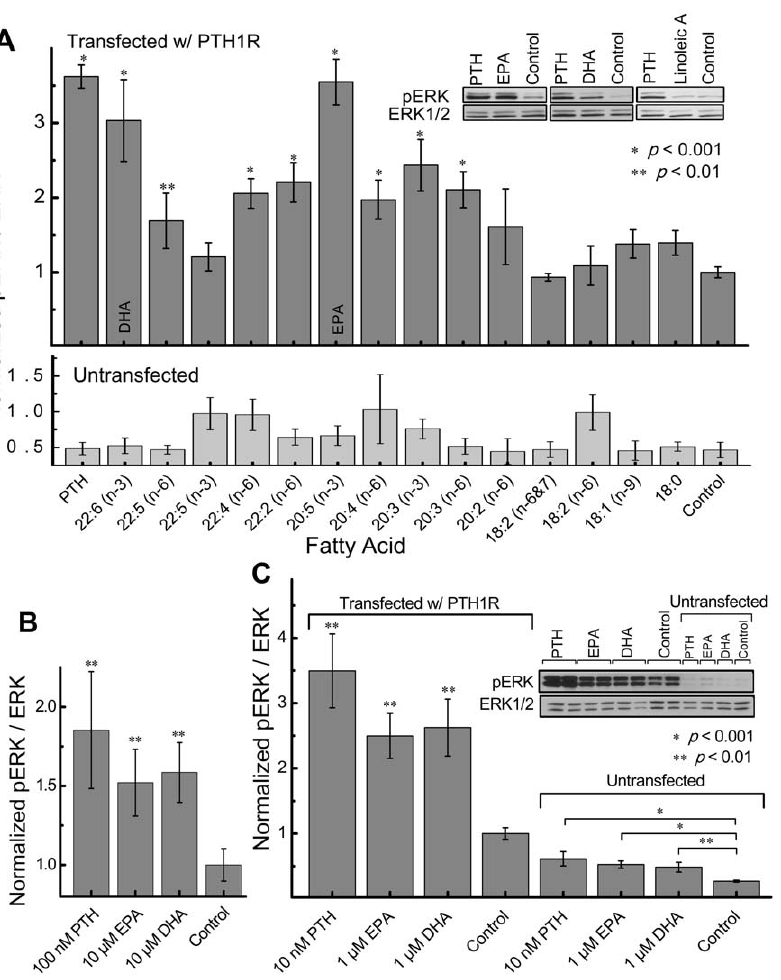
Figure 1. Activation of PTH1R by fatty acids in (A, B) HEK293 and (C) MC3T3-E1 cells. PTH(1–34) concentration in (A, B) was 100 nM (positive control). Fatty acids concentrations were 10 m M. HEK293 cells were transfected with PTH1R as described under Materials & Methods and treated for (A) 5 minutes or (B) 15 seconds. (C) PTH(1–34) concentration was 10 nM (positive control). Fatty acid concentrations were 1 m M. MC3T3-E1 cells were transfected with PTH1R as described under Materials & Methods. Cells were stimulated with PTH(1–34) or corresponding fatty acid in PBS for 5 minutes at 37 u C. Western blots were used to determine ERK1/2 phosphorylation. Data represent mean of n $ 6 experiments. Error bars indicate standard error of the mean